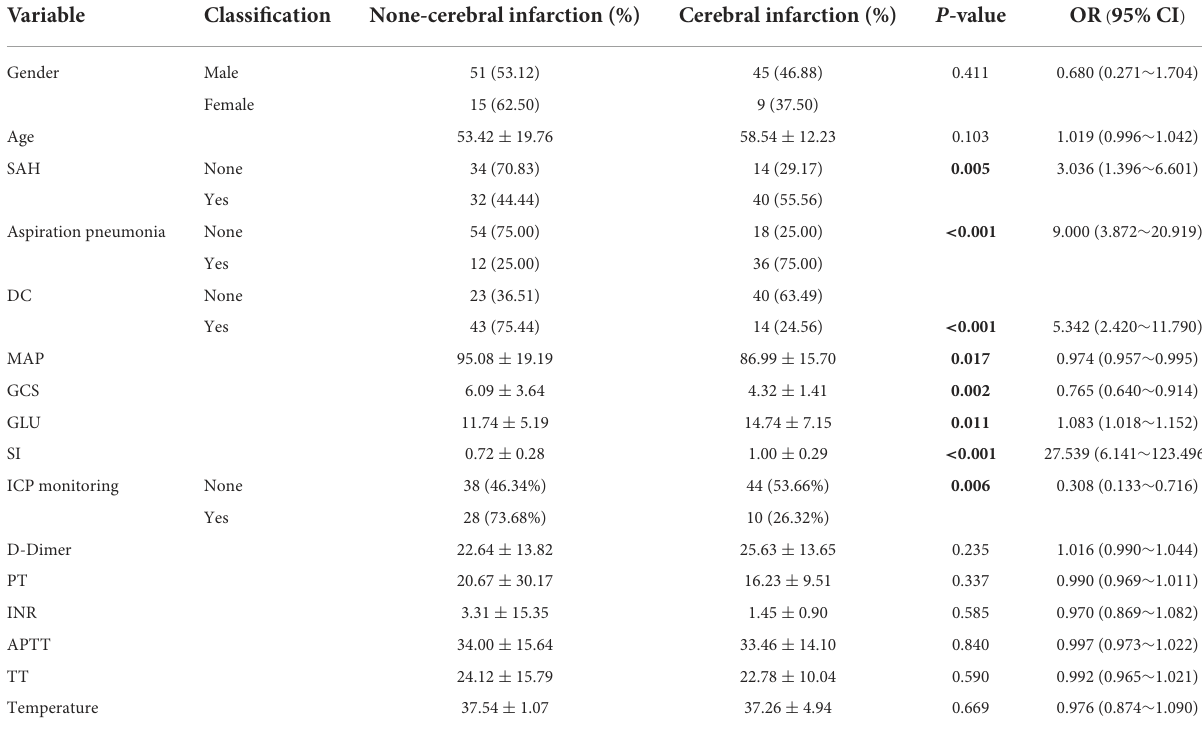
TABLE 2 Univariate analysis of PTCI-related variables in 120 patients with TBI and herniation. Variable